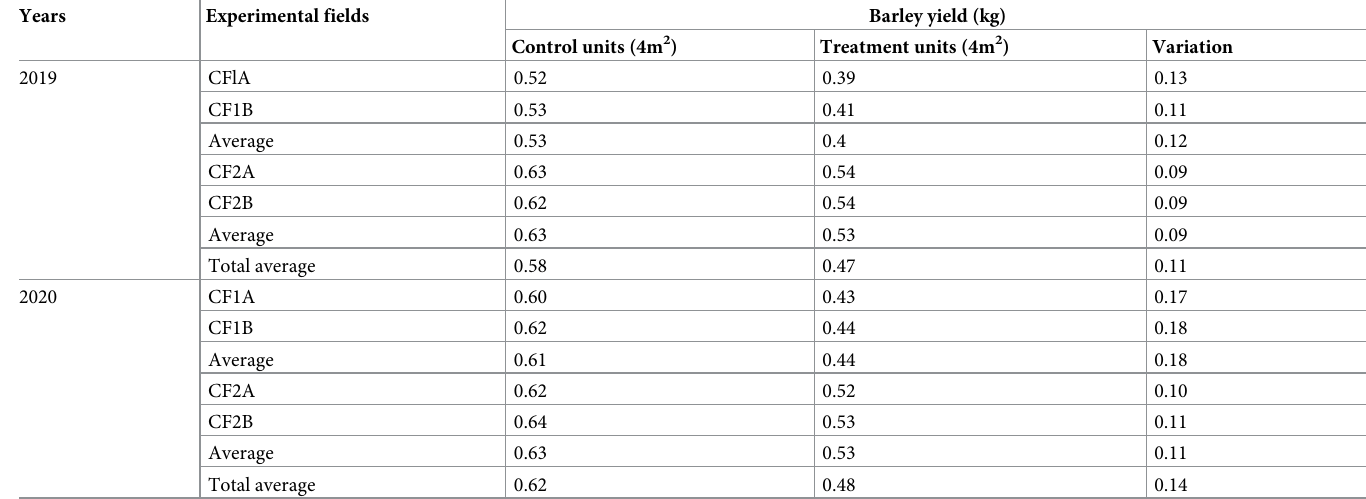
Table 4. Estimated pre-harvest yield loss of barley crop (CF1A, B = crop fields near the forest, CF2A,B = crop fields away from the forest).